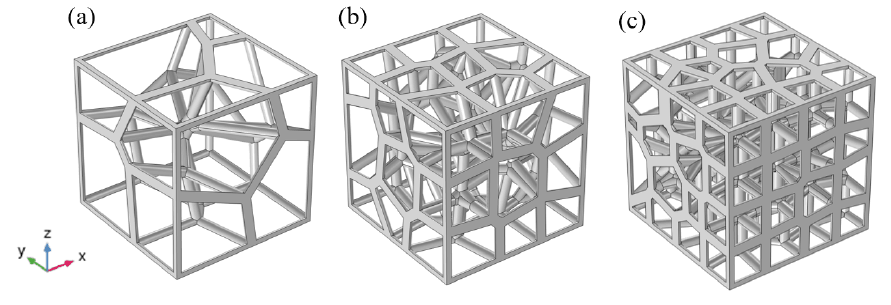
Figure 2. Strut-based gradient Voronoi structures: ( a ) Gradient Voronoi structure consisting of 2 × 2 × 2 units (GV2). ( b ) Gradient Voronoi structure consisting of 3 × 3 × 3 units (GV3). ( c ) Gradient Voronoi structure consisting of 4 × 4 × 4 units